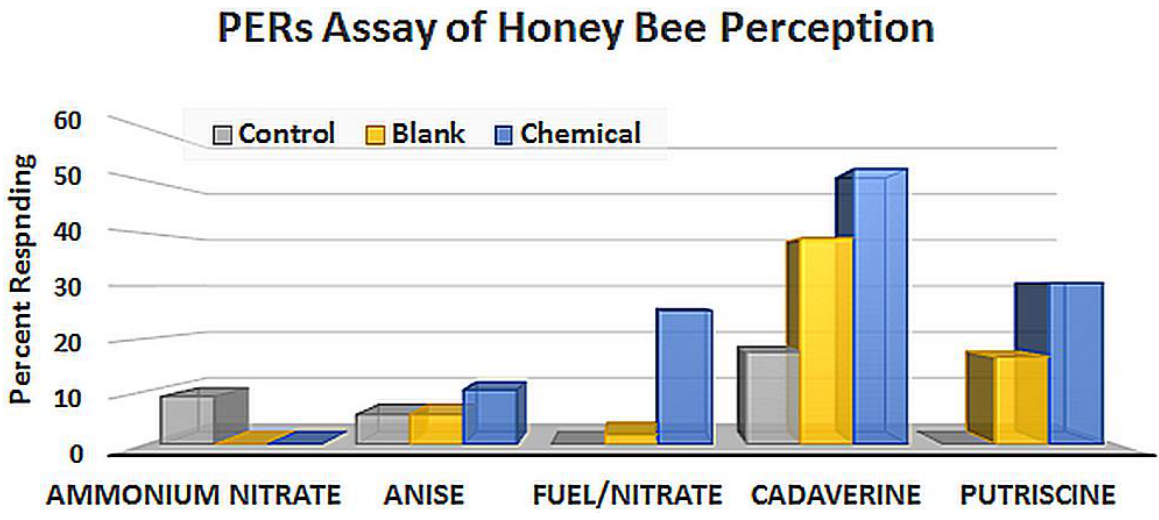
Figure 1. PERs results for chemical detection of fertilizer, fertilizer-based bombs, and decomposition products of animal carcasses compared to anise, a floral